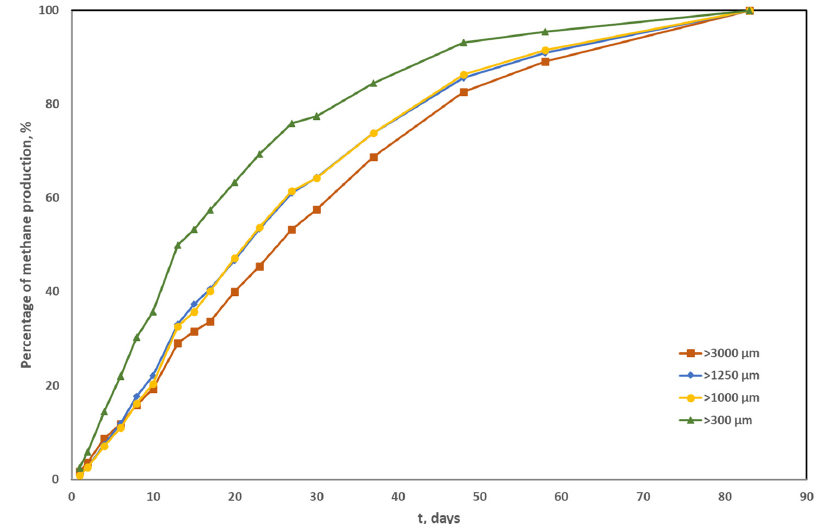
Figure 7. Volume release of methane as a percentage of total net volume, as a function of the fermentation time estimated from the biochemical methane potential measurement of solid samples collected from sieves with certain sizes of openings.